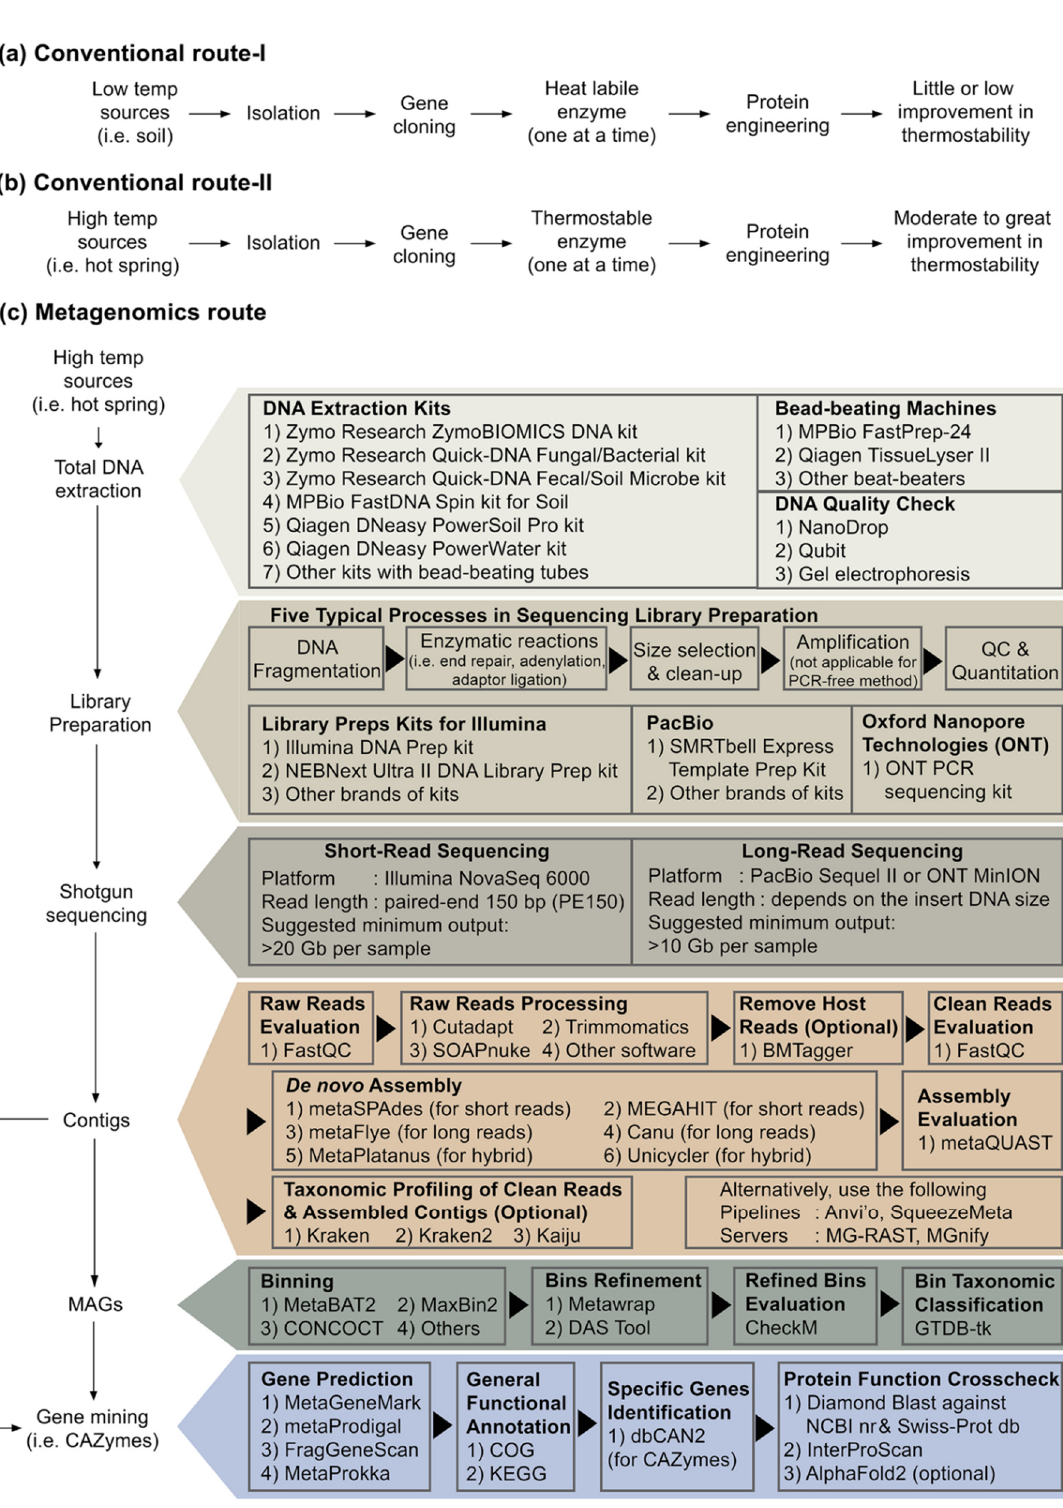
Figure 5. Research flow chart to find novel active and thermostable pullulan-degrading enzymes: ( a ) Conventional route using a low or moderate temperature initial resources (i.e., soil or water). Low throughput approach. ( b ) Conventional path using a high-temperature initial resource (i.e., hot spring, vent, etc.). Low throughput approach but may obtain excellent thermostable enzymes. ( c ) Metagenomic-driven route using high-temperature initial resources. High throughput, more costly and computationally intensive methodology.